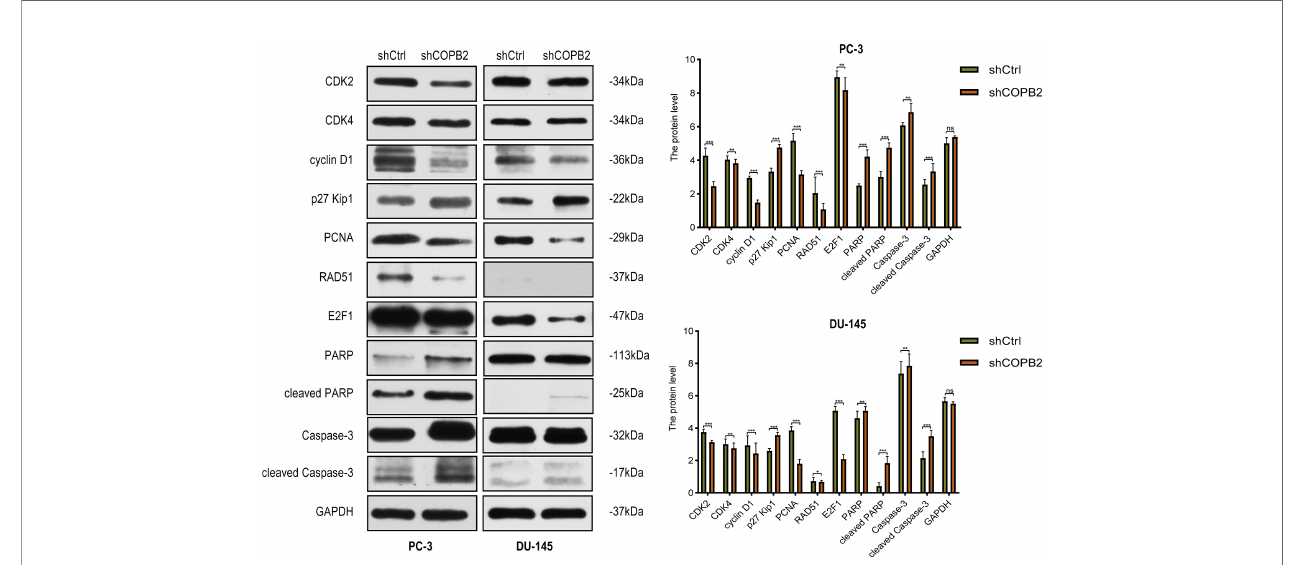
FIGURE 5 | Cell cycle and apoptosis signaling pathways mediated COPB2-induced proliferation of PC-3 and DU-145 cells. Western blot analysis of CDK2, CDK4, cyclin D1, p27 Kip1, PCNA, RAD51, E2F1, PARP, cleaved PARP, Caspase-3 and cleaved Caspase-3 in shCOPB2 and shCtrl groups in two PCa cell lines. * P < 0.05, ** P < 0.01, *** P < 0.001, ns, not signi fi